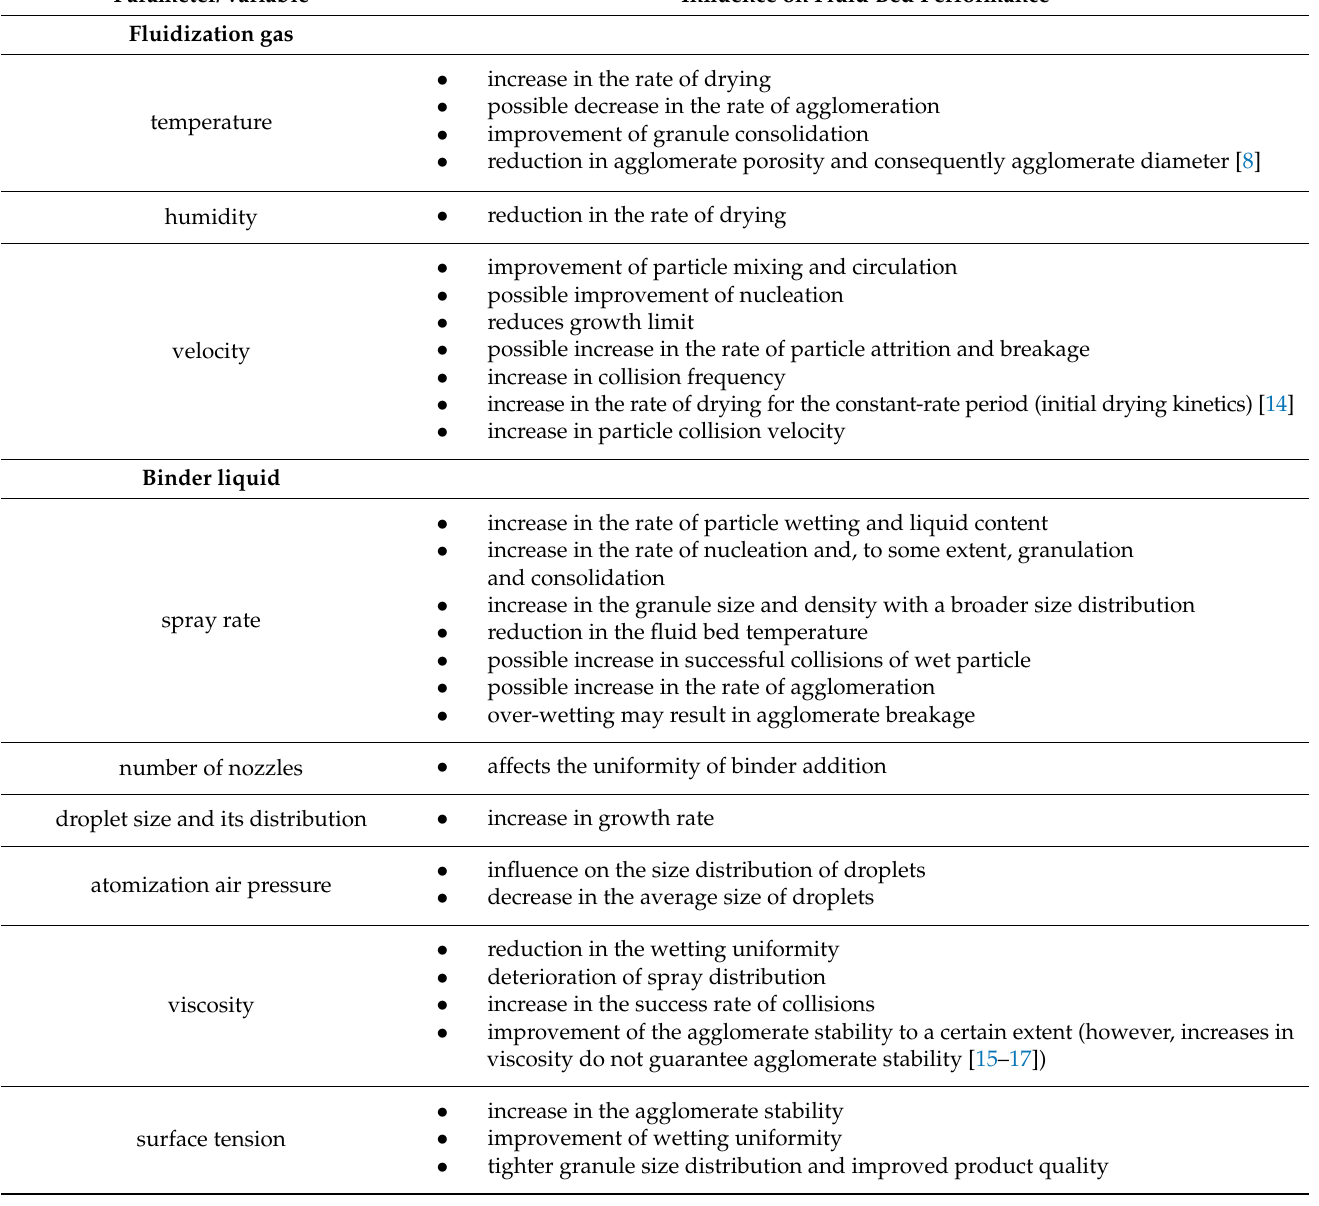
Table 1. List of key parameters and variables influencing fluid bed granulation performance (upon an increase in each of the parameters)